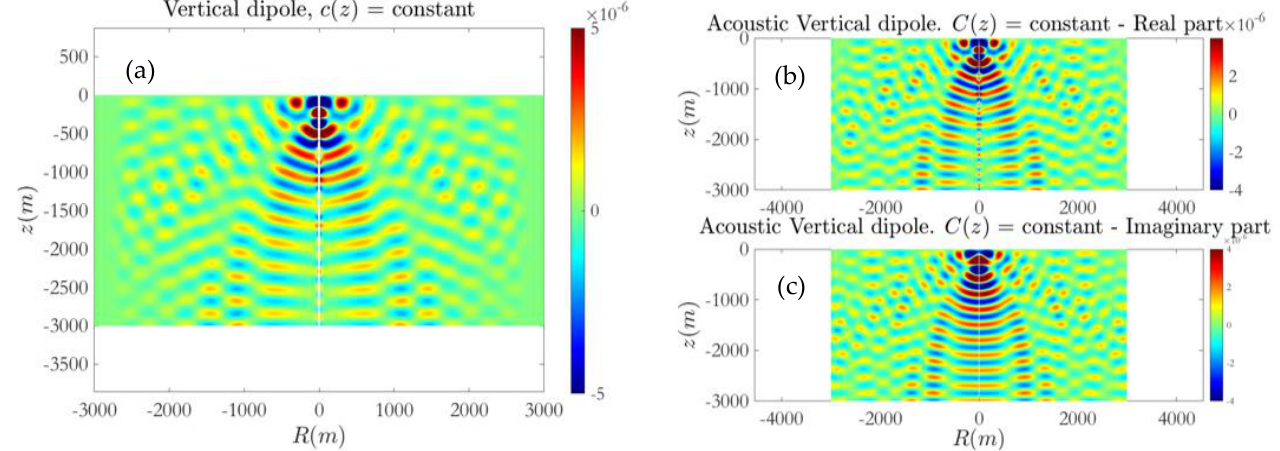
Figure 10. ( a ) The calculated acoustic field for the isovelocity environment, obtained using the present FDTD–PML numerical scheme, excited by a vertical dipole source of frequency f = 5 Hz located at a depth of 300 m, at the end of the computation time after 15 periods. ( b , c ) Real and imaginary parts of the acoustic field solution of the Helmholtz equation excited by a vertical dipole source of frequency f = 5 Hz located at a depth of 300 m. phenomena that manifest at higher frequencies. In particular, the effect of the free surface and hard bottom modifies the noise pattern